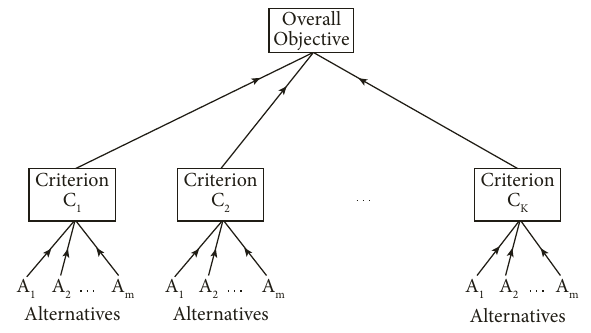
Figure 4: Hierarchical structure [12]. Table 6: Fuzzy values by percentile.